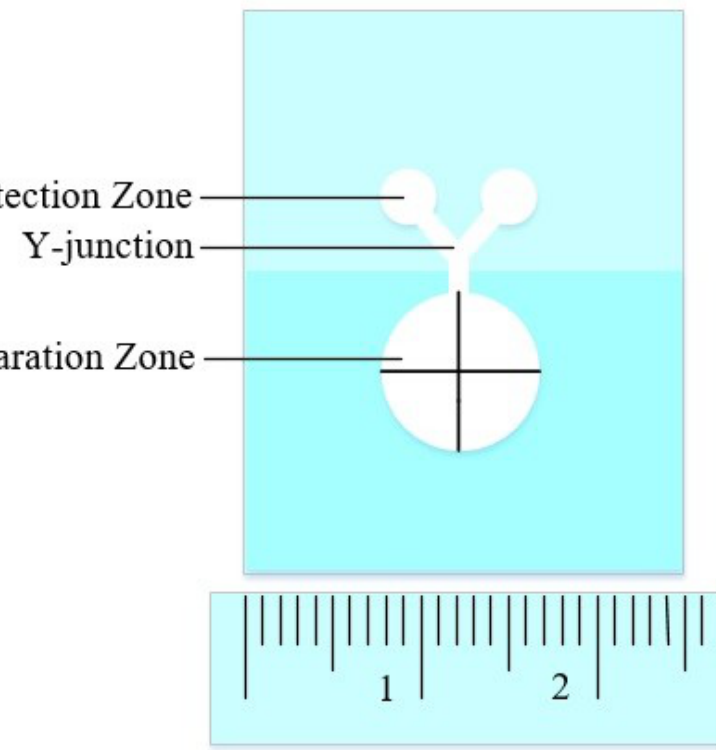
Figure 2. Paper-based microfluidic chip for blood cell separation.